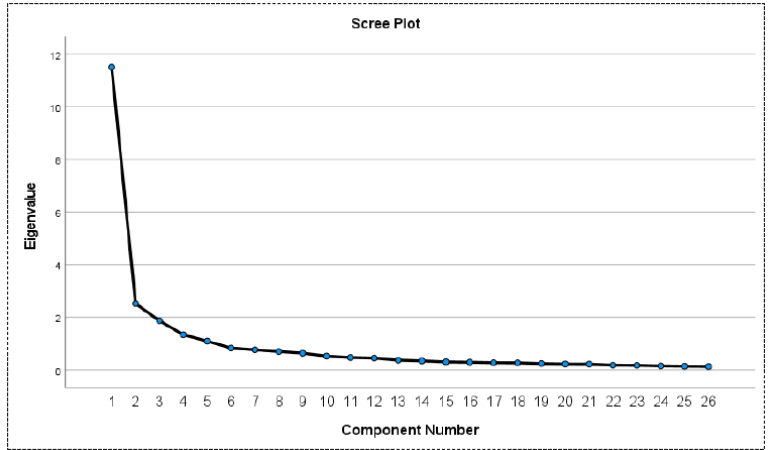
Figure 1. EFA scree plot.